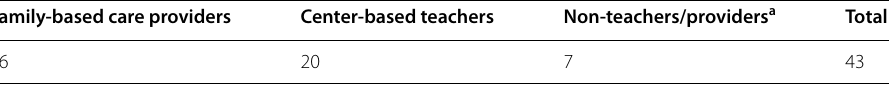
Table 1 Semi-structured interviews: cross-context data